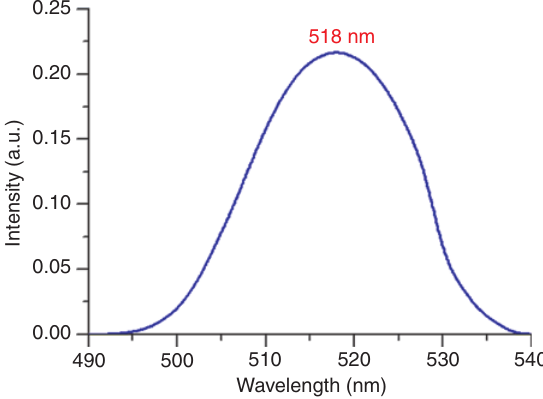
Figure 6: Solid-state fluorescence emission spectra of as-prepared MnO 2